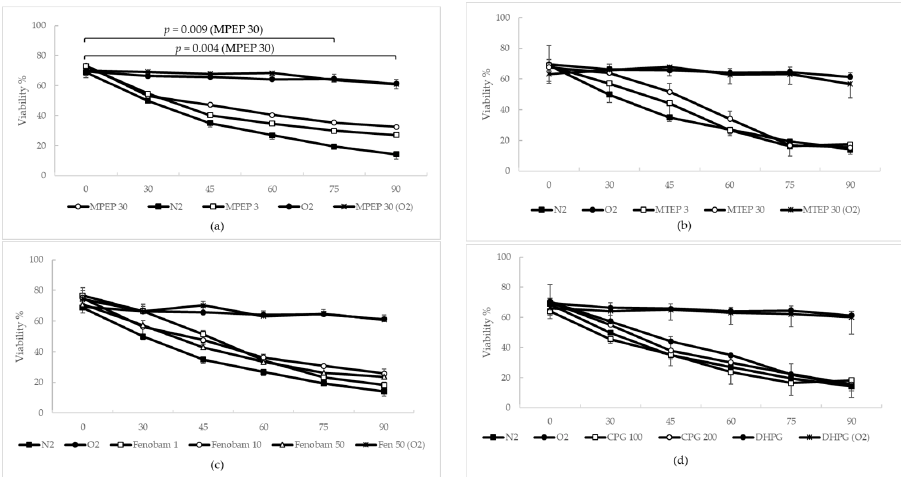
Figure 4. MPEP improves the viability (measured by LDH release) of hypoxic hepatocytes: ( a ) a statistical difference was observed in the 0 ′ –90 ′ time range, between anoxic cells treated with MPEP 30 µM ( p = 0.004, linear mixed-effects fitting analysis) and the corresponding untreated anoxic controls. The significance for this comparison decreased in the 0 ′ –75 ′ time range ( p = 0.009) and further decreased in the 0 ′ –60 ′ time range ( p = 0.048); ( b ) no statistical difference was observed, by means of linear mixed-effects fitting analysis or Tukey’s Test, for MTEP, although mortality rates showed a similar trend compared with that observed using TB exclusion; ( c ) no statistical difference was observed, by means of linear mixed-effects fitting analysis or Tukey’s Test, for fenobam, although mortality rates were similar to the rates observed using TB exclusion; ( d ) no statistical difference was observed using linear mixed-effects fitting analysis or Tukey’s Test for CPG, an orthosteric antagonist.